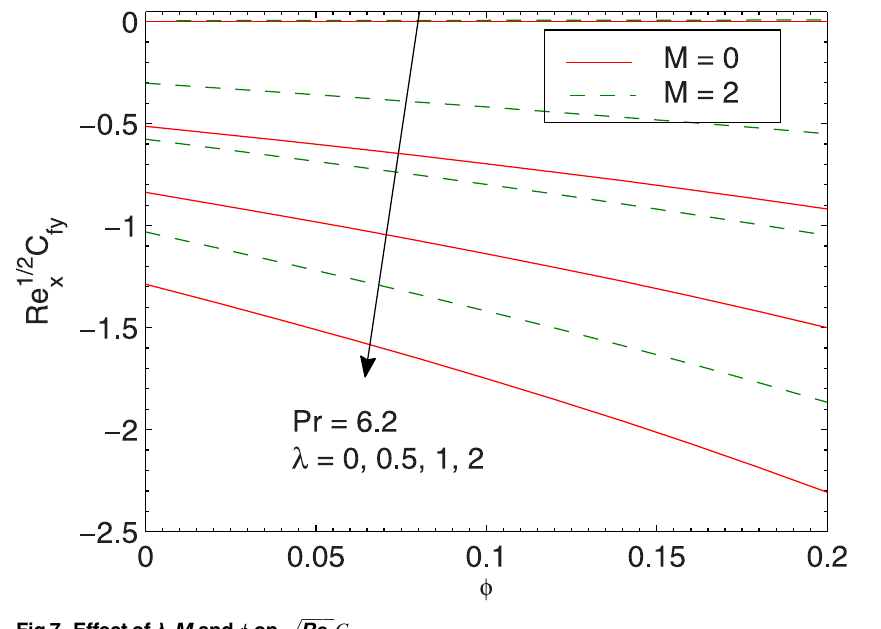
Fig 7. Effect of λ , M and ϕ on